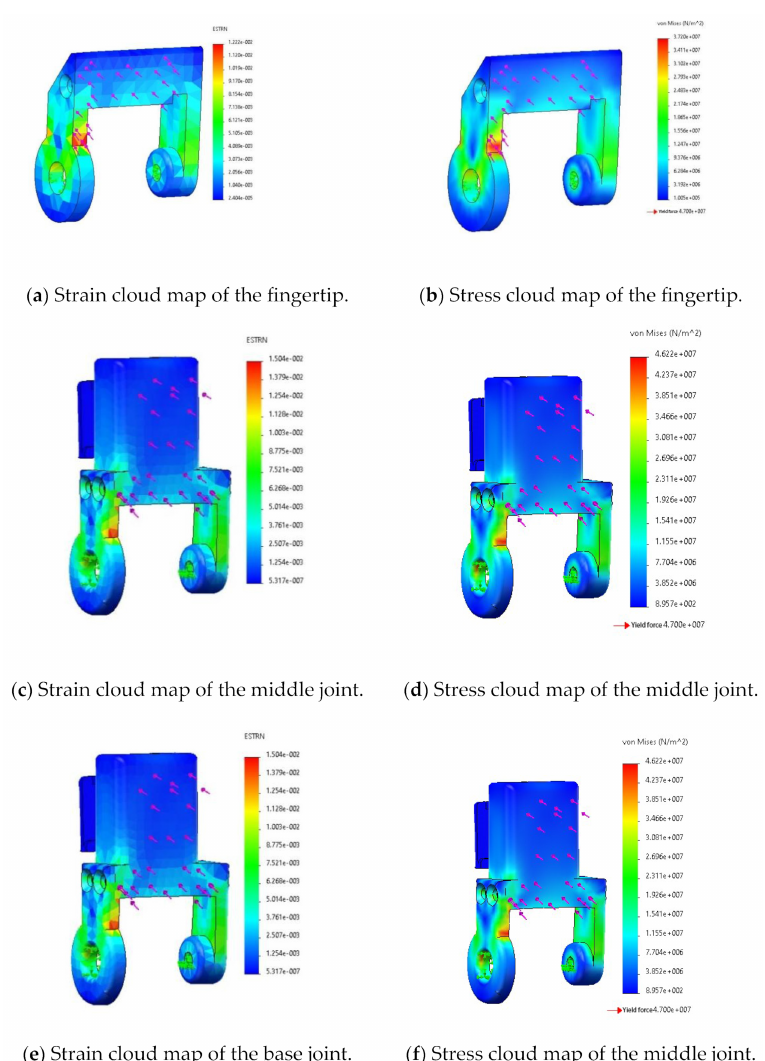
Figure 8. Results of joint finite element